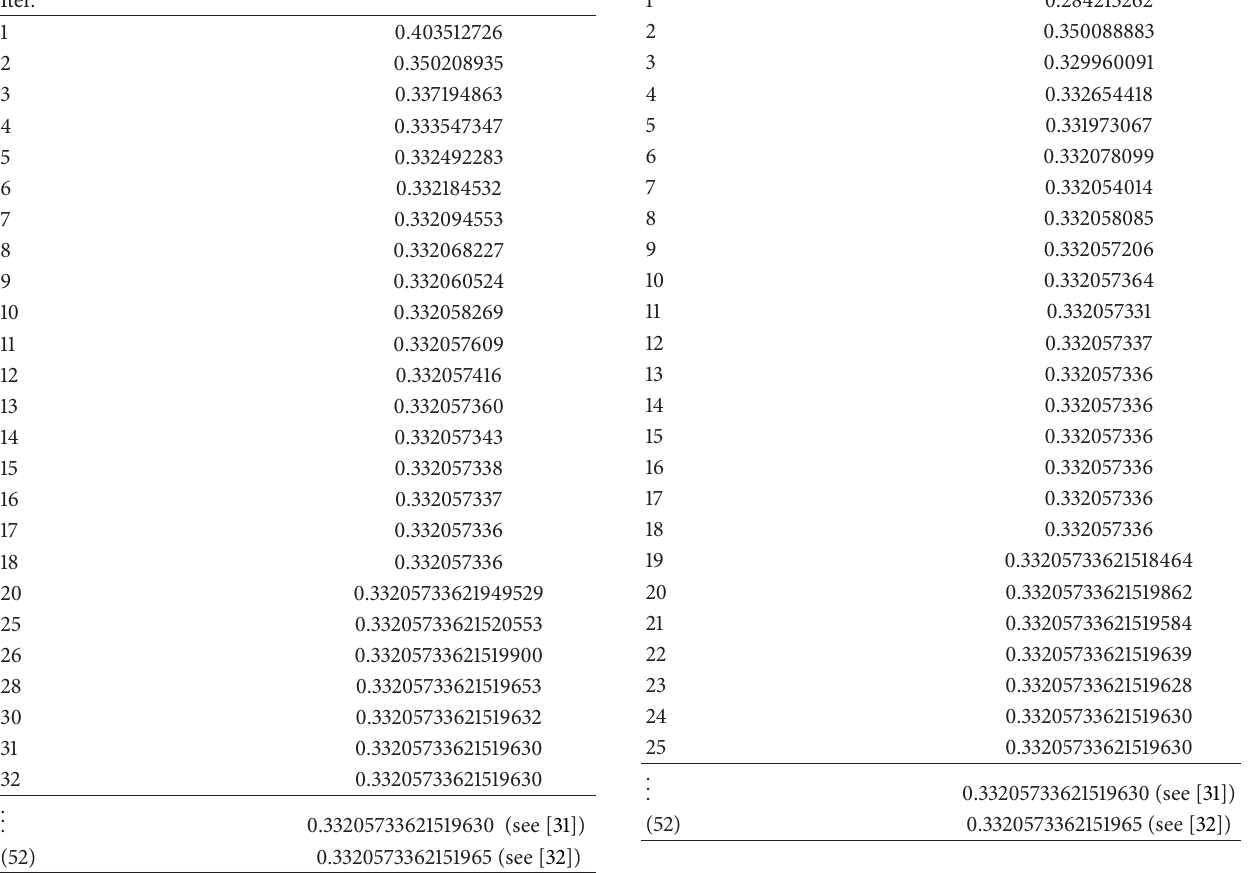
Table 1: Comparison between the basic SLLM computed values of 𝑓 󸀠󸀠 (0) for the Blasius flow against the results of [31, 32]. Iter.